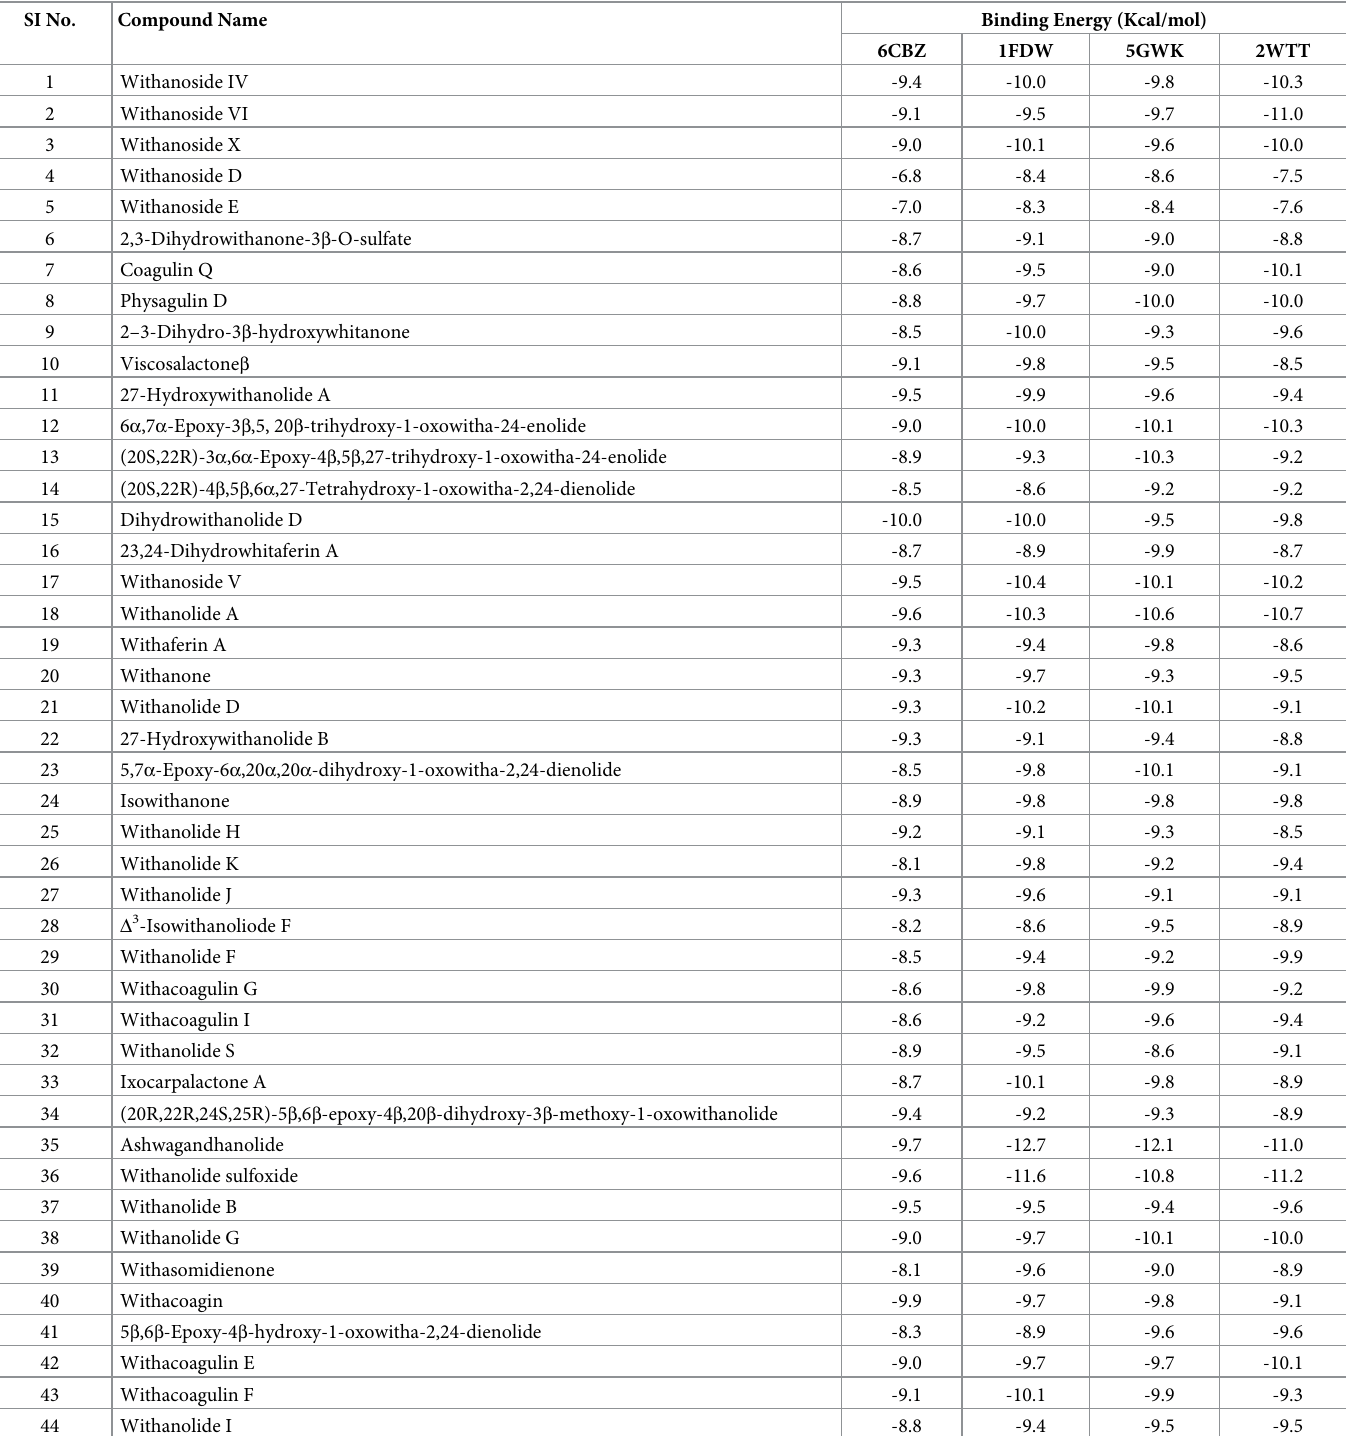
Table 1. Molecular docking results of phytochemicals isolated from W. somnifera against four different proteins expressed during breast cancer. SI